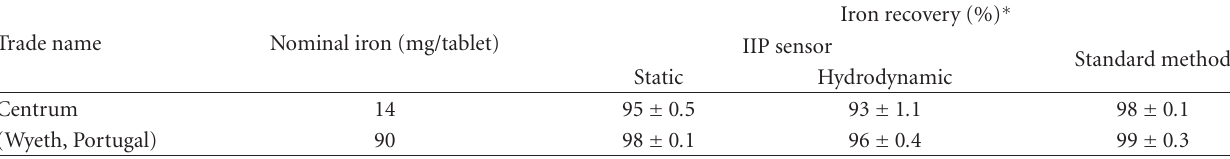
Table 2: Potentiometric determination of iron in some pharmaceutical formulation samples using the proposed ferroin sensors.